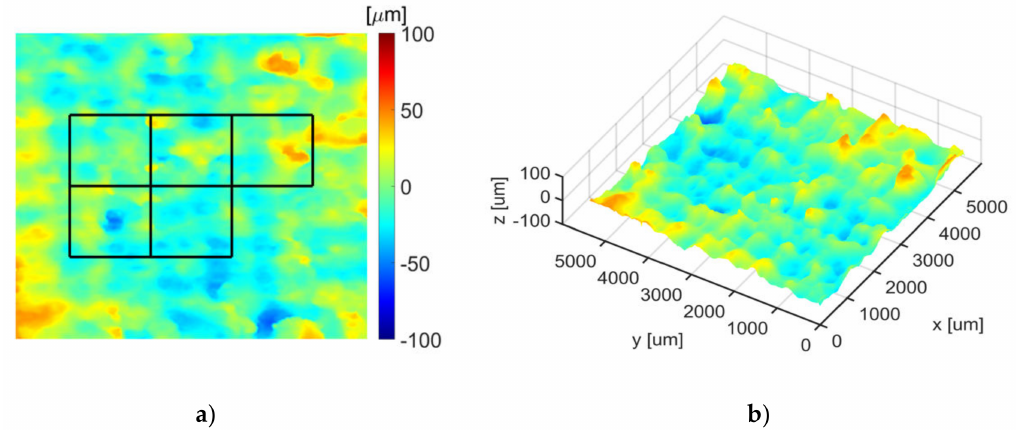
Figure 9. Example depth map of Cordura surface with an Ag layer, scanned in the OCT view field relative to the approximated base plane: ( a ) plane view; ( b ) perspective view.